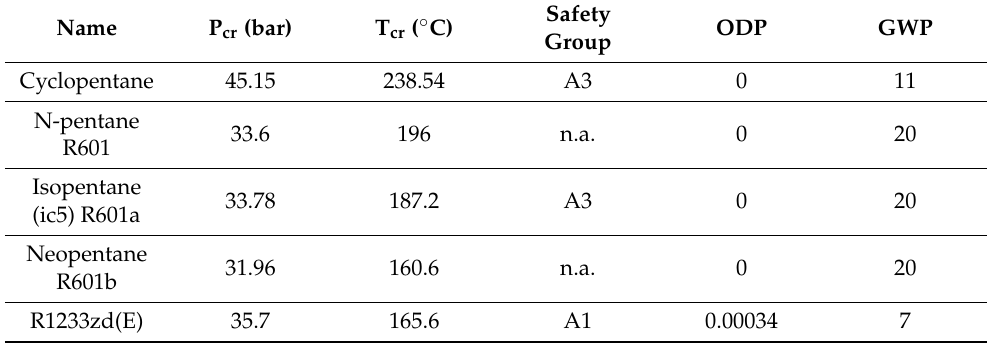
Table 3. Model parameters used in the simulations for the SORC and DP ORC